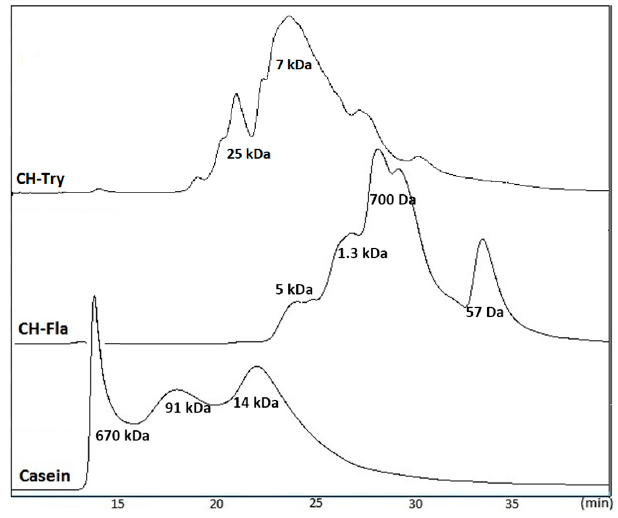
Figure 2. Size exclusion chromatograms of casein hydrolysates using different enzyme treatments at an E:S ratio of 1:50 under 100 MPa for 1 h.